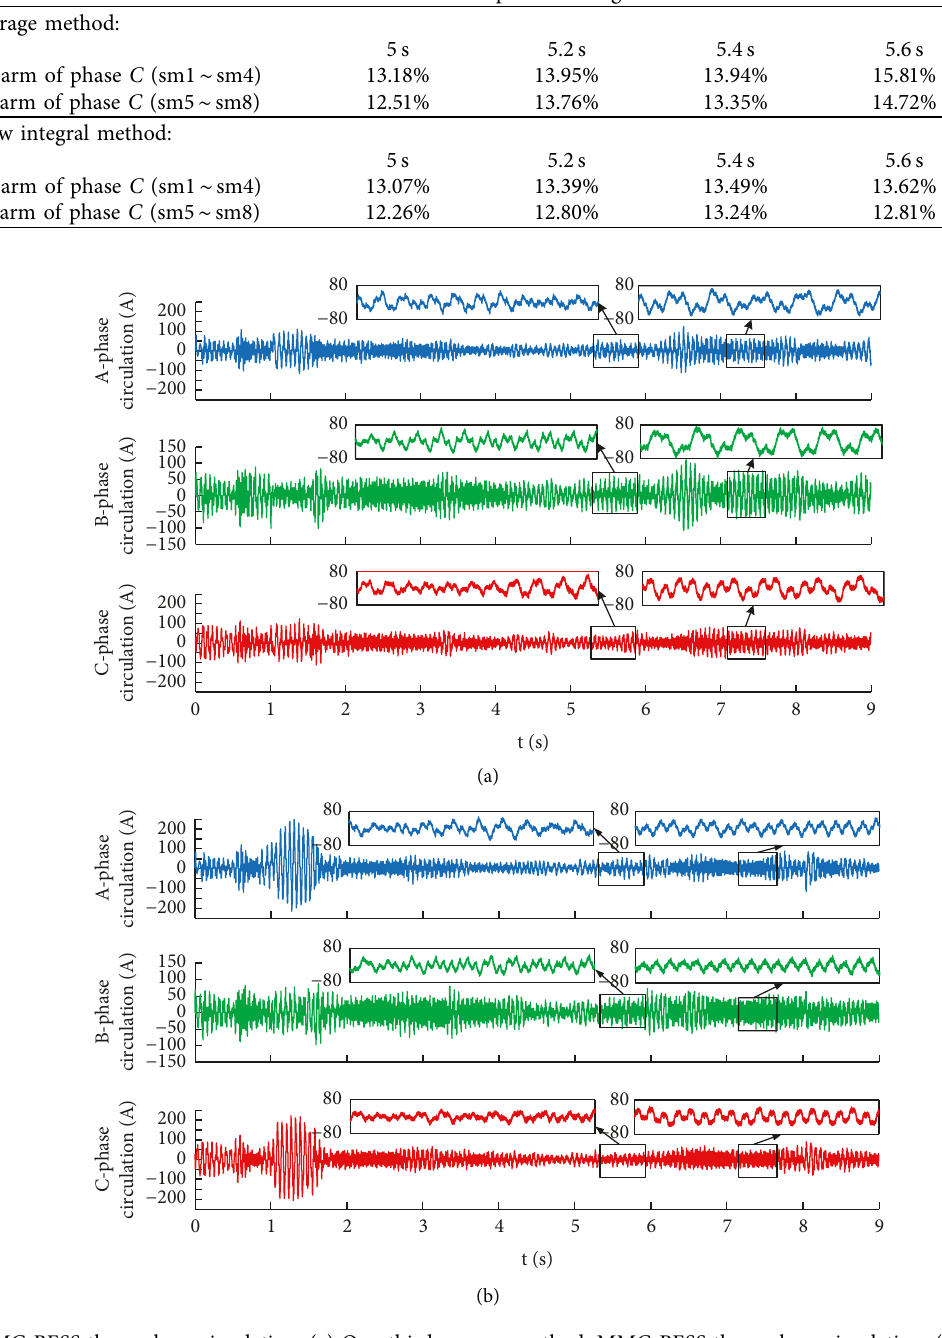
Figure 21: MMC-BESS three-phase circulation. (a) One-third average method, MMC-BESS three-phase circulation. (b) Sliding window integral method, MMC-BESS three-phase circulation.